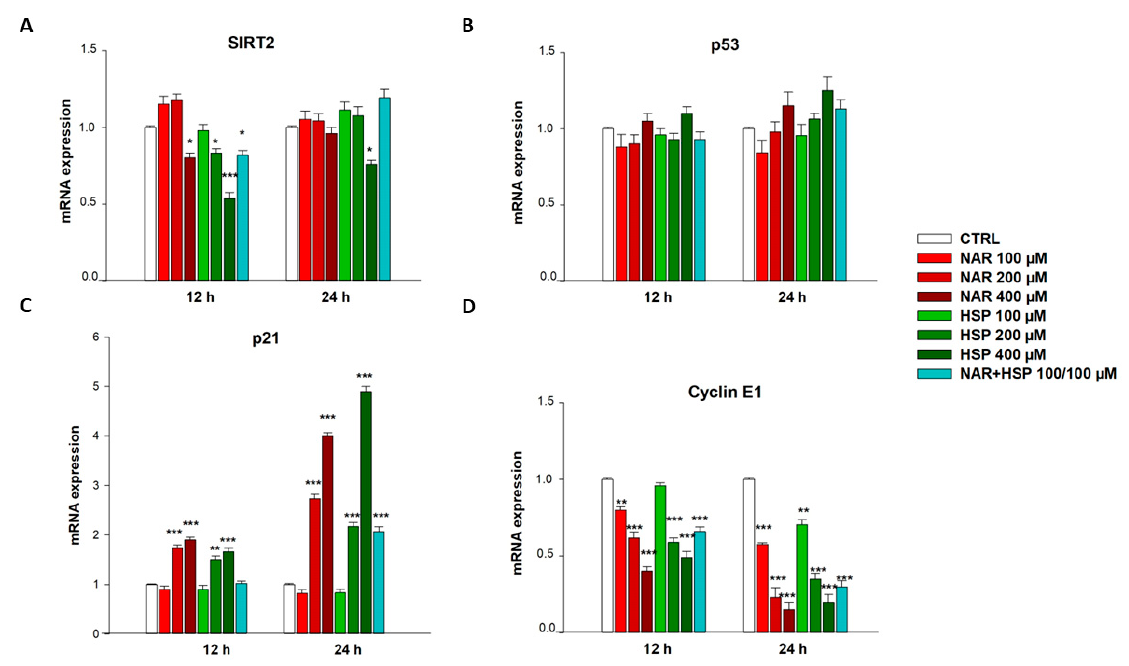
Figure 8. Modulation of SIRT2 ( A ), p53 ( B ), p21 ( C ), and cyclin E1 ( D ) gene expression after treatment with NAR (red bars) and HSP (green bars), as well as their combination (light blue bars), in THP-1 cells for 12 and 24 h. The mRNA levels were quantified by real-time PCR, and their relative quantities were calculated through the 2 – ∆∆ CT method. Results are expressed as fold change relative to untreated cells. Data are expressed as mean ± SEM of three separate experiments in triplicate ( n = 9). * p < 0.05, ** p < 0.01, and *** p < 0.001 vs.